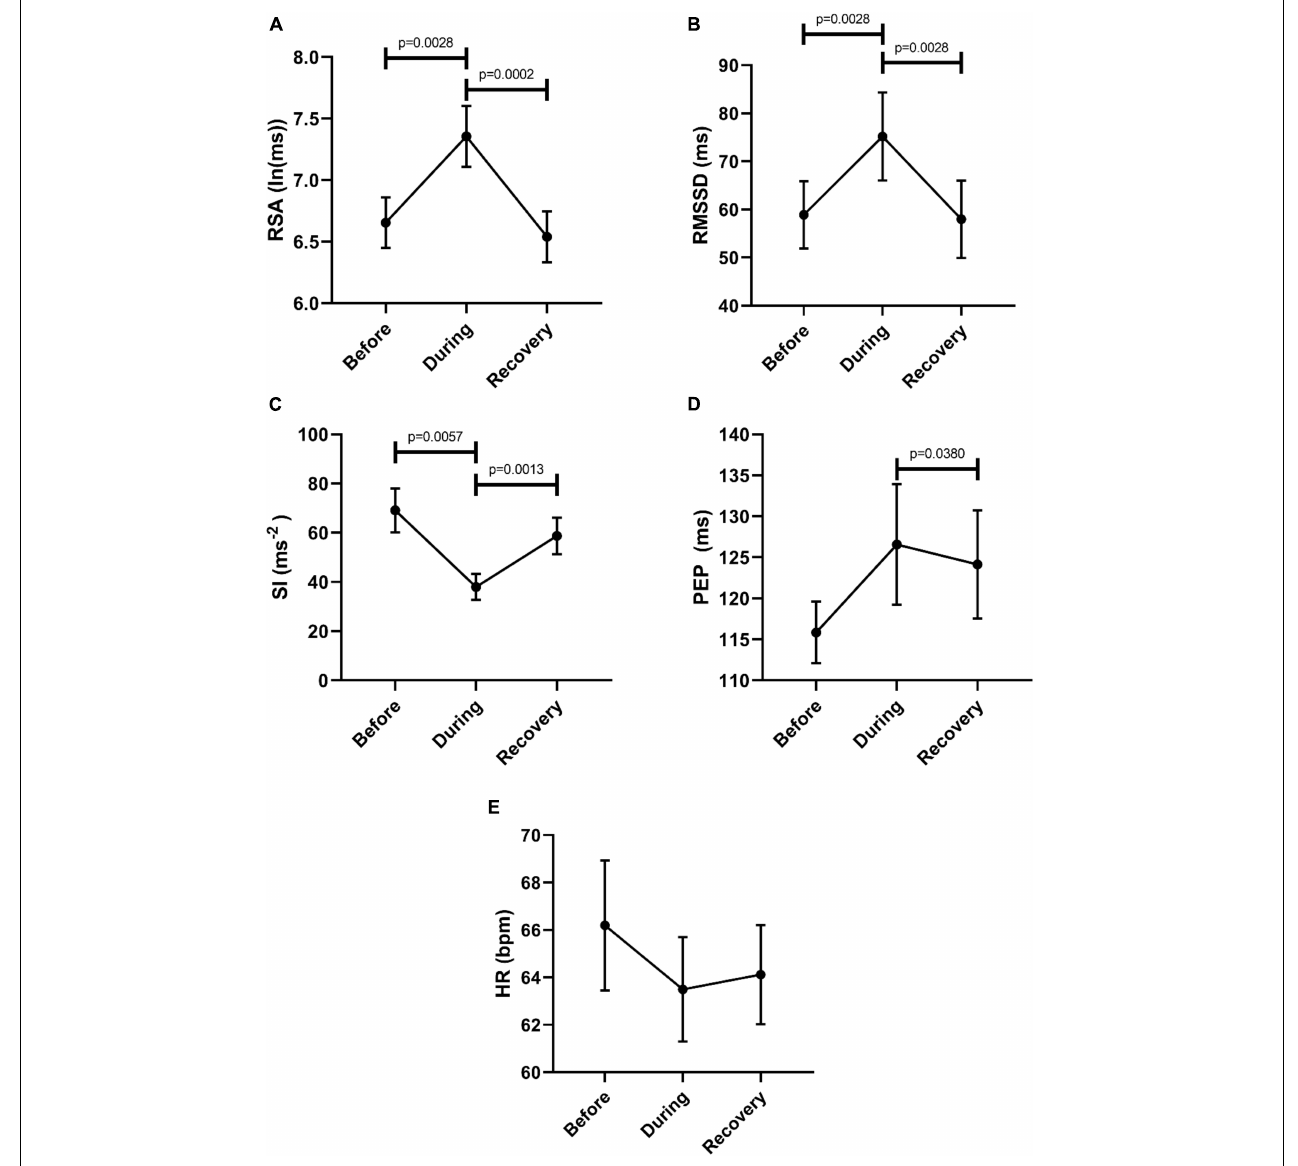
FIGURE 3 | Changes in autonomic activity in response to all motor patterns. Data sets are derived by averaging all 145 motor patterns within subjects, hence n = 11. The Friedman test was applied for assessment of significance, followed by the Dunn’s multiple comparisons test. (A) RSA increased significantly during the motor activity and recovered within 2 min. (B) RMSSD increased significantly during the motor activity and recovered. (C) SI decreased significantly during the motor activity. (D) PEP decreased significantly after motor activity. (E) Heart rate remained